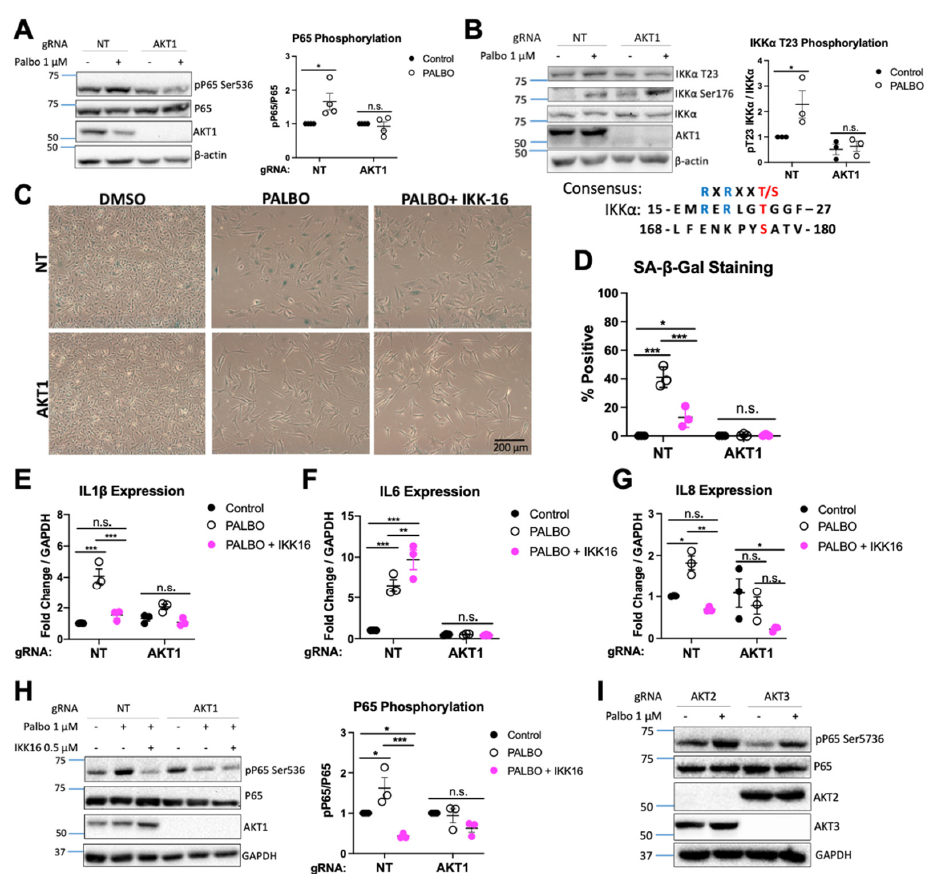
Figure 4. AKT1 regulates IKK leading to NF- κ B-mediated SASP production ( A ). Representative Western blot of cells treated with PALBO for 7 days at 1 μ M with quantification of phospho-P65 over total P65 normalized to untreated cells for n = 4 independent experiments. ( B ). Representative Western blot of IKK α phosphorylation of cells treated with PALBO for 1 week at 1 μ M with quantification of phospho-P65 over total P65 normalized to untreated cells for n = 3 independent experiments, AKT consensus site at T23 aligned with S176 in IKK α . ( C ). Beta-galactosidase staining of cells treated for 7 days with PALBO (1 μΜ ) alone or in combination with IKK inhibitor IKK-16 (0.5 μΜ ). ( D ). Representative Western blot of NT or AKT1 cells treated for 7 days with PALBO alone or in combination with IKK-16. ( E – G ). SASP induction in cells treated with PALBO alone or in combination with IKK-16 for 1 week. ( H ). Representative Western blot of cells treated with PALBO (1 μΜ ) alone or in combination with IKK inhibitor IKK-16 (0.5 μΜ ) with quantification of phospho-P65 over total P65 normalized to untreated cells. ( I ). Representative Western blot of bulk AKT2/3 KO cells treated with PALBO for 7 days at 1 μ M. Significance determined by Student’s t -test (Panel ( A , B )) or two-way ANOVA with multiple comparisons (Panel ( E – G )) (* = p < 0.05, ** = p < 0.01, *** = p < 0.001, n.s. = no significance). The uncropped blots are shown in Supplementary Materials.